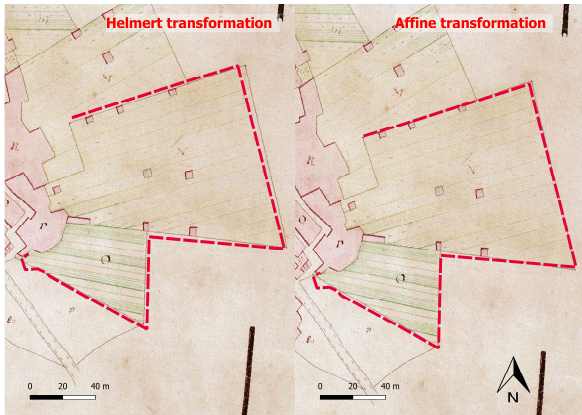
Figure 8 . Comparison between Helmert and Affine transformations.